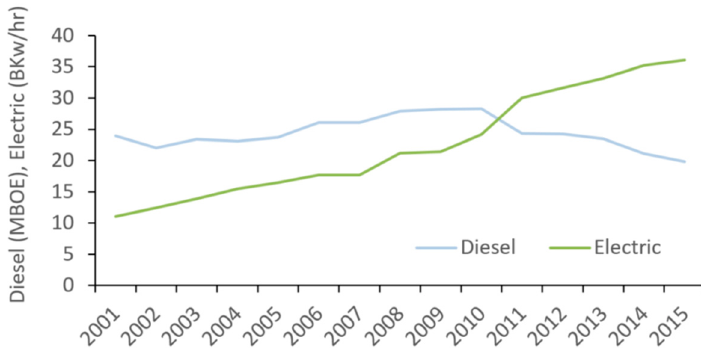
Figure 9. Electric and diesel energy consumption in Iran’s agricultural sector.